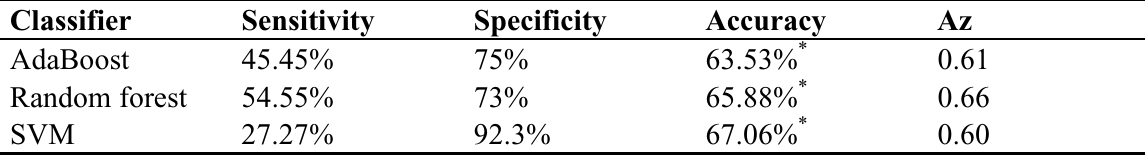
Table 5. Performance comparison among three classifiers without GMM features.